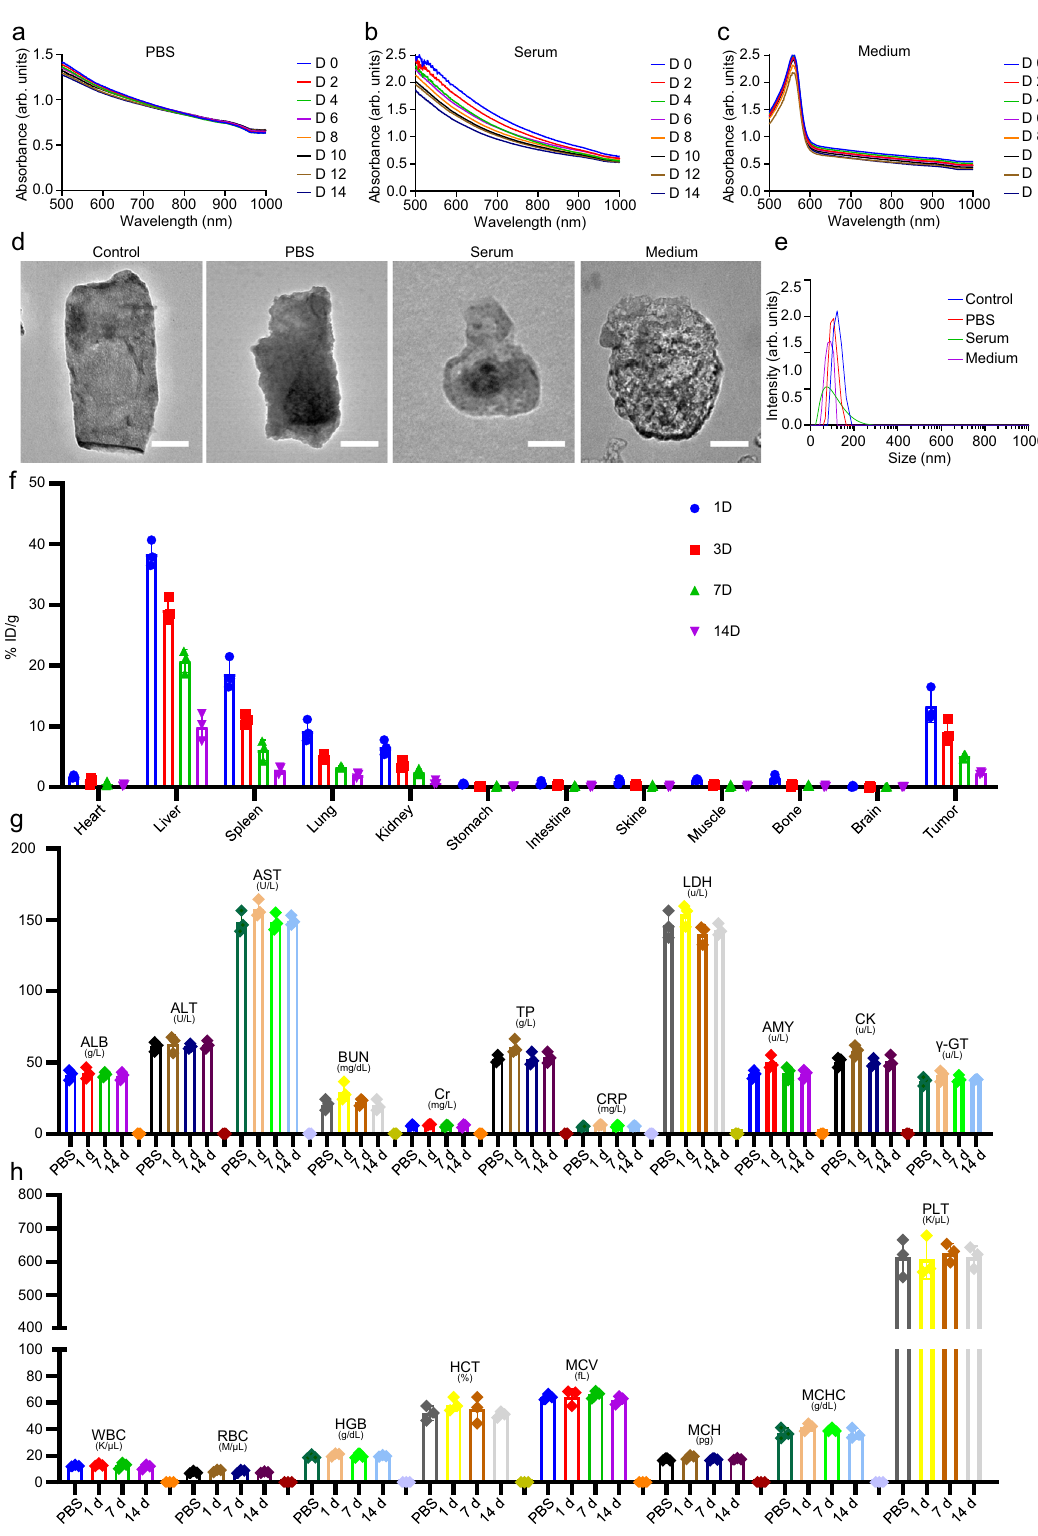
Fig. 10 Biodegradation behavior of FeOCl/FeOOH NSs. UV-vis-NIR absorbance spectra of layered FeOCl/FeOOH NSs co-incubated with a PBS, b serum and c medium solution for 14 days. The units (arb. units) of UV – Vis absorbance spectra and XPS spectra mean arbitrary units. d TEM images of layered FeOCl/FeOOH NSs and FeOCl/FeOOH NSs co-incubated with PBS, serum, and medium solution for 14 days, scale bar = 50nm. For these TEM images of FeOCl/FeOOH NSs, three times each experiment was repeated independently with similar results. e Size distribution of layered FeOCl/FeOOH NSs and FeOCl/FeOOH NSs co- incubated with PBS, serum, and medium solution for 14 days. f Biodistribution of FeOCl/FeOOH NSs in tumor-bearing mice by ICP measurement. The data show mean±s.d., n = 3 biologically independent mice. g Blood biochemistry analysis of Balb/c mice treated with PBS or FeOCl/FeOOH NSs. h Blood hematology analysis of Balb/c mice treated with PBS or FeOCl/FeOOH NSs. Data are presented as mean±s.d. ( n = 3 biologically independent mice). Source data are provided as a Source Data fi